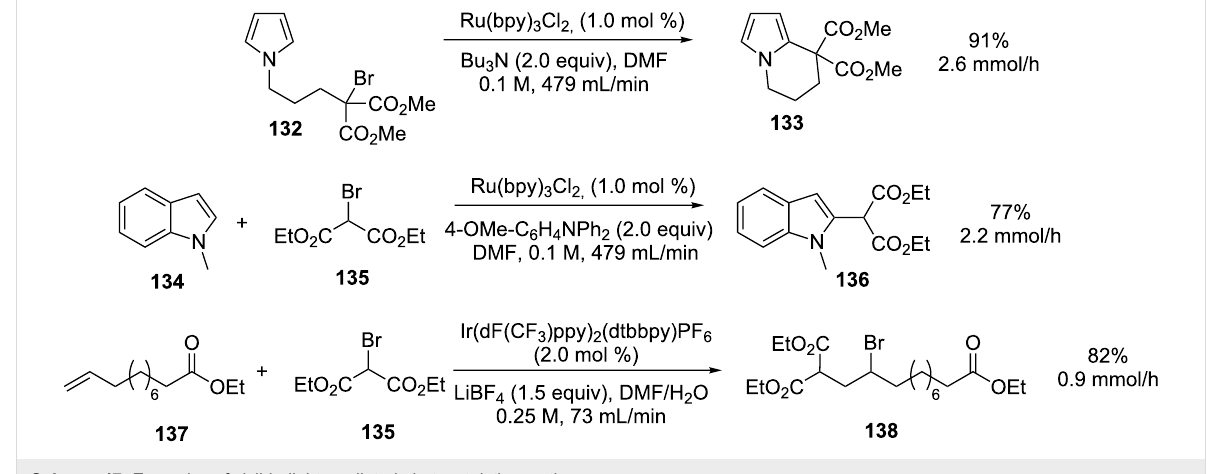
Scheme 47: Examples of visible-light-mediated photocatalytic reactions.